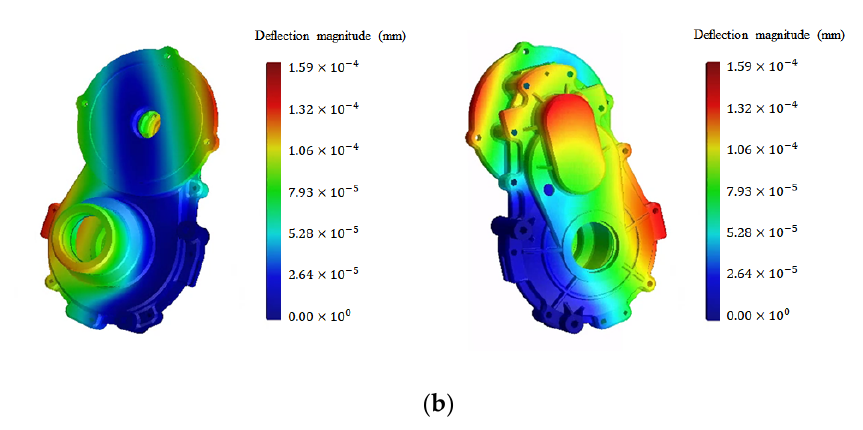
Figure 14. Operating deflection shape for counterclockwise drive. ( a ): ODS excited by gear mesh stage 1-first harmonic at 3788 rpm; ( b ): ODS excited by gear mesh stage 1-second harmonic at 2724 rpm.